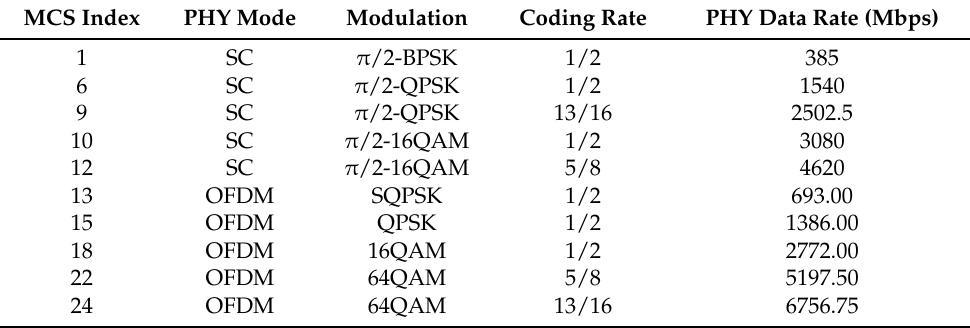
Table 1. Modulation and coding scheme examples of IEEE 802.11ad (BPSK: Binary Phase-Shift